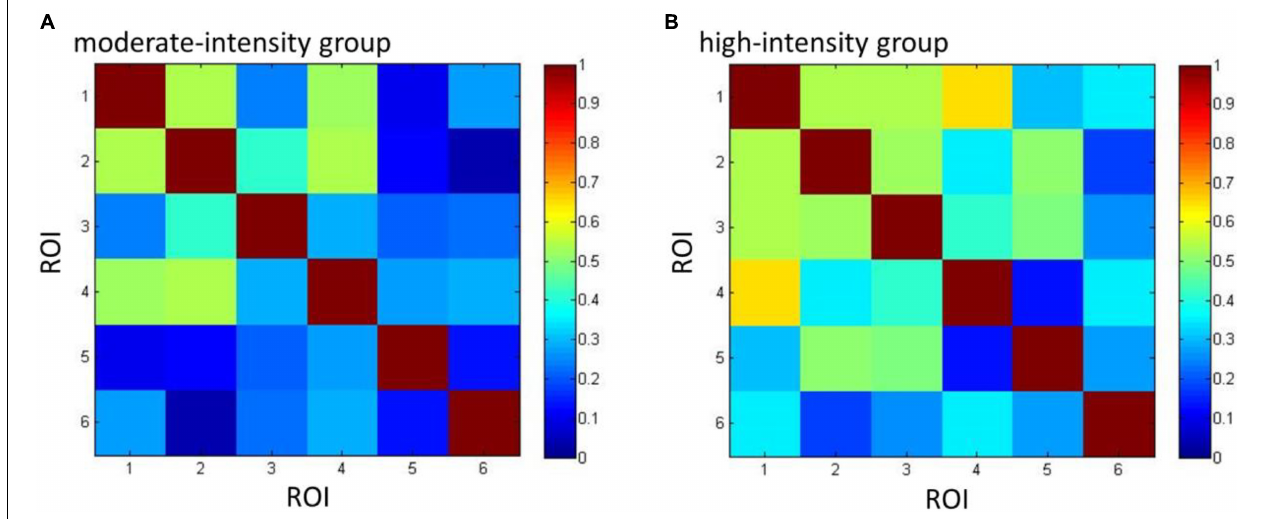
FIGURE 6 | The connectivity matrices of moderate- (A) and high-intensity (B) groups. Numbers 1–6 represent the ROIs (1 = FPA, 2 = OFC, 3 = VLPFC_L, 4 = VLPFC_R, 5 = DLPFC_L, 6 = DLPFC_R) and colors represent the mean group-level Pearson’s correlation between each pair of